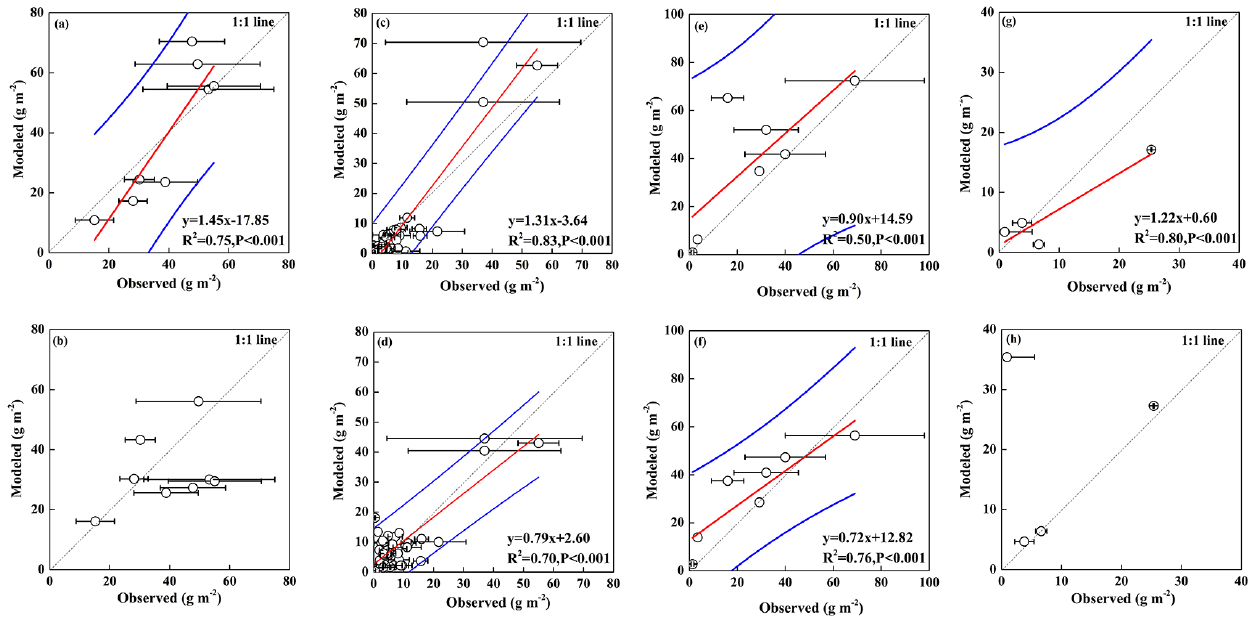
Figure 4. Regressions of simulated against observed total amount of seasonal/annual CH 4 emissions from marsh sites by CH4MOD wetland (a) and TEM (b) , from peatland sites by CH4MOD wetland (c) and the TEM (d) , from swamp sites by CH4MOD wetland (e) and TEM (f) , and from coastal wetland sites by CH4MOD wetland (g) and TEM (h) . The horizontal bars are the standard errors from the sampling replicates at the wetland site. The blue line is the prediction correspondence. The dashed line is the 1:1